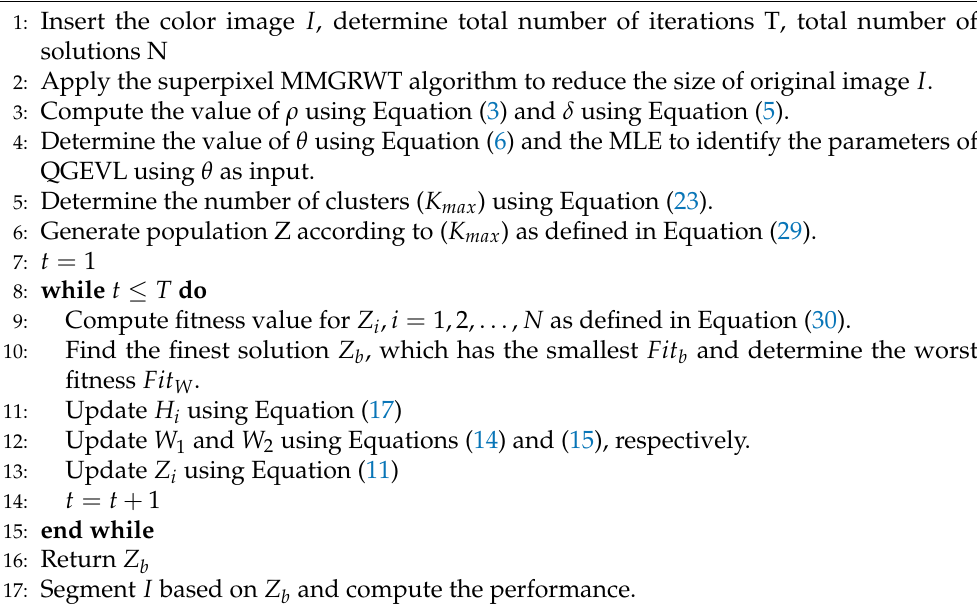
Algorithm 2 Steps of developed ASCQPHGS clustering for color